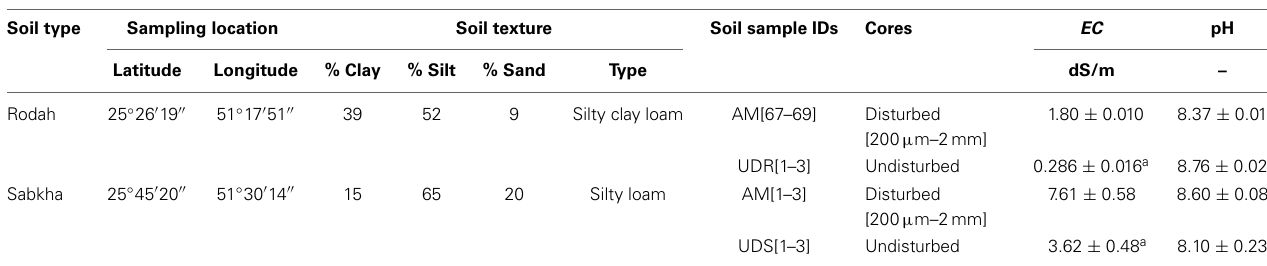
Table 1 | General description of the soil samples used in the study. Soil